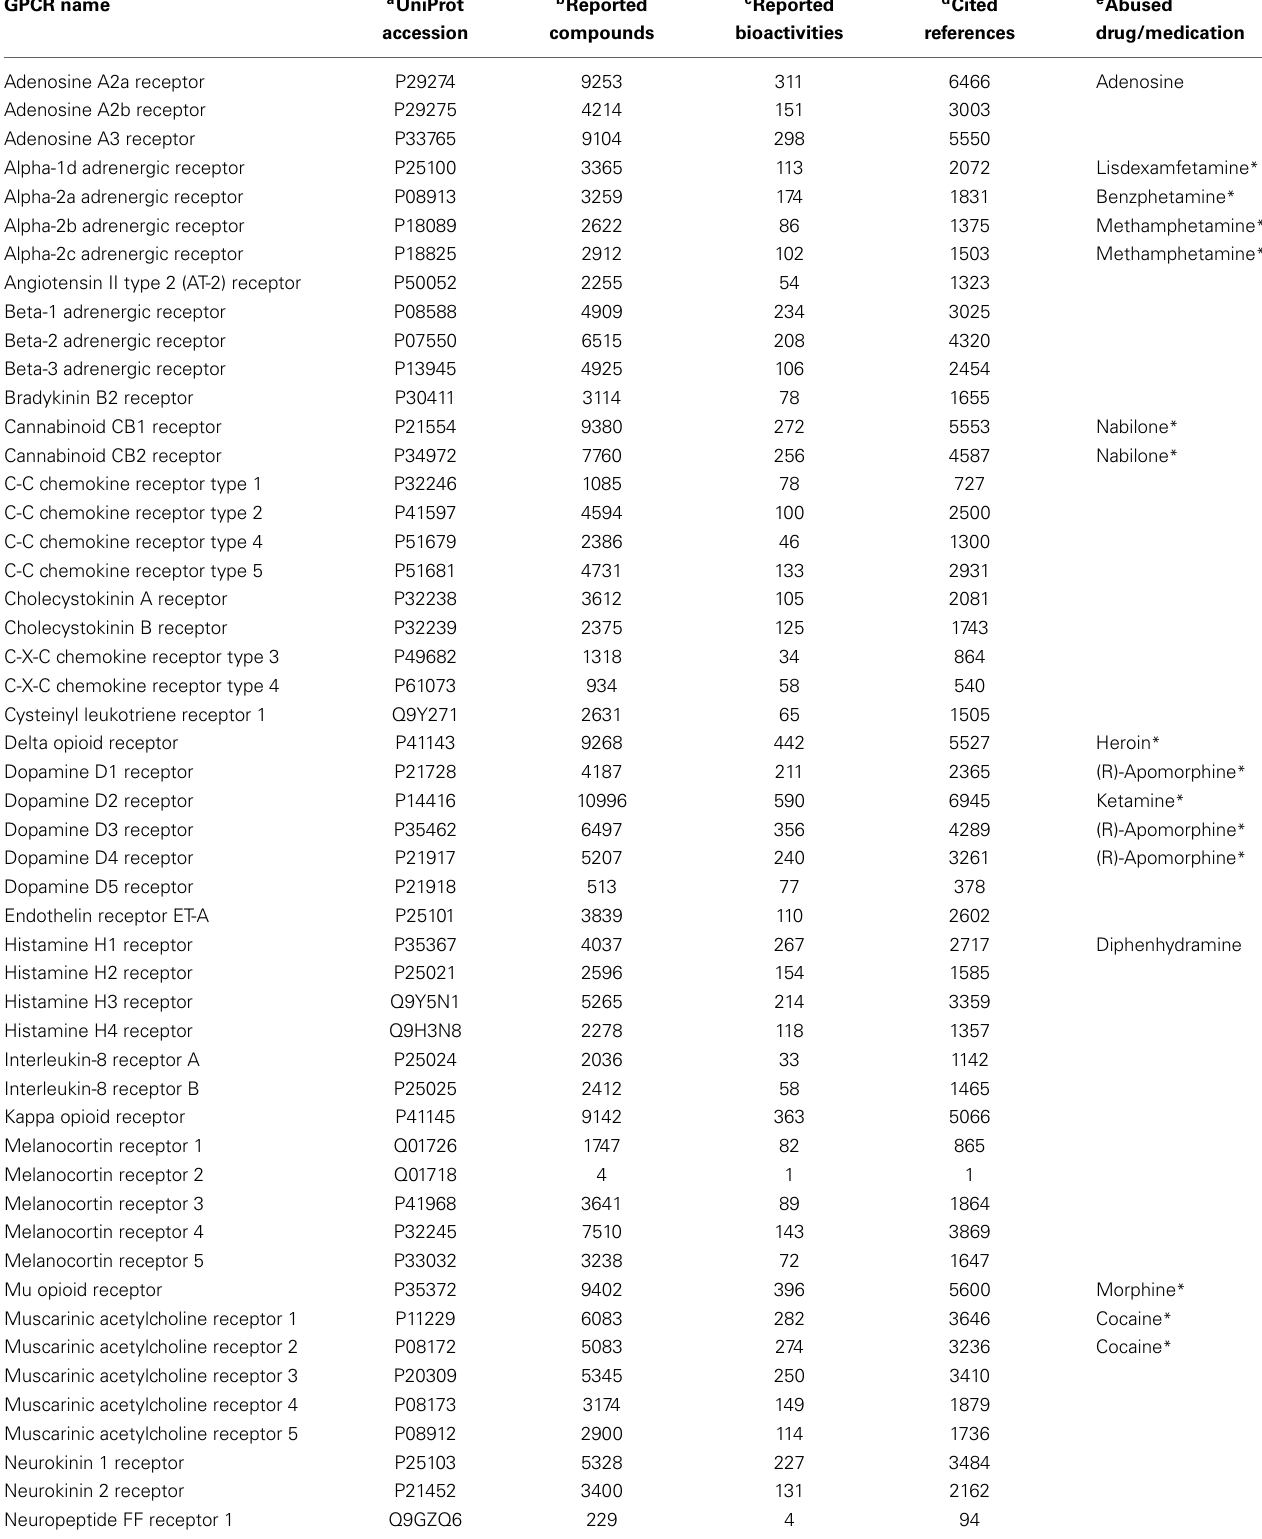
Table 1 | List of drug-abuse related GPCRs in the DA-KB